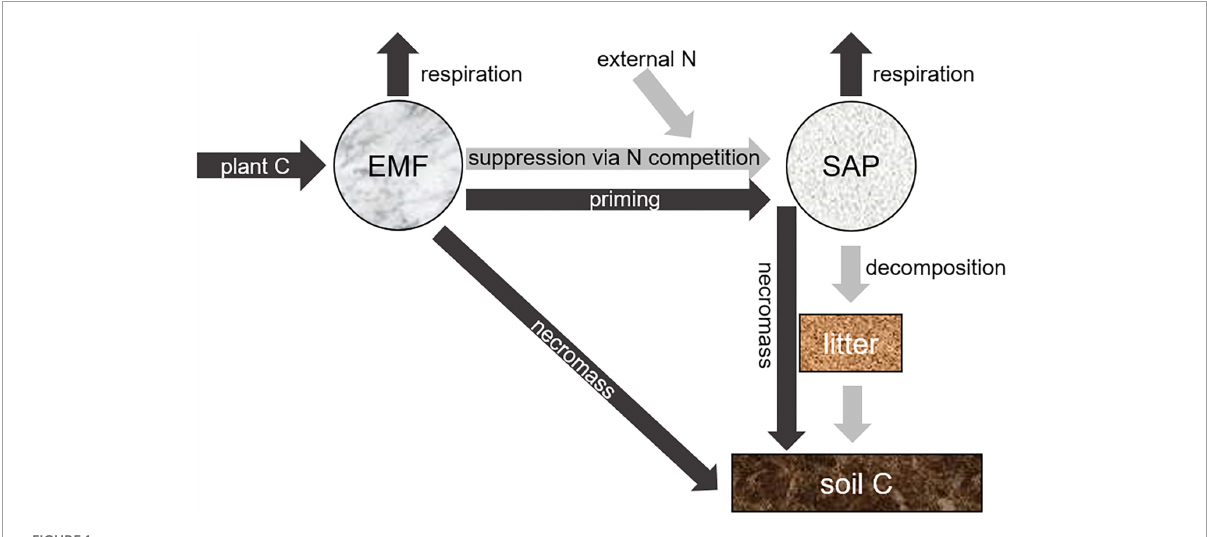
FIGURE1 Diagram showing the influence of ectomycorrhizal fungi (EMF) on soil carbon (C) accumulation through two potential pathways. The first pathway is nitrogen (N)-centered (light-gray arrows), in which saprotrophs (SAP) were suppressed by EMF via N competition. We asked if external N fertilization can relieve the N suppression and stimulate SAP. The second pathway is C-centered (dark-gray arrows), in which EMF transfer plant-derived C to the soil C through microbial necromass. We asked whether the plant C transported to EMF can significantly contribute to microbial biomass, or would have mainly been consumed through microbial